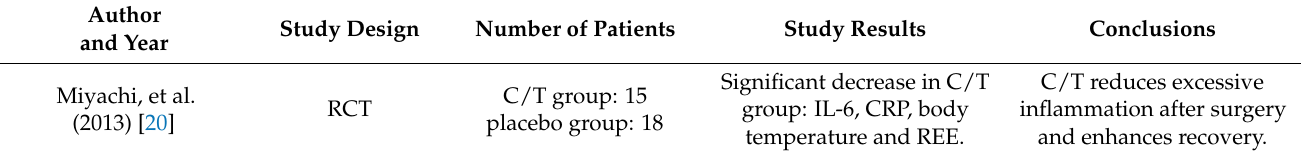
Table 1. Clinical study of cystine/theanine for perioperative